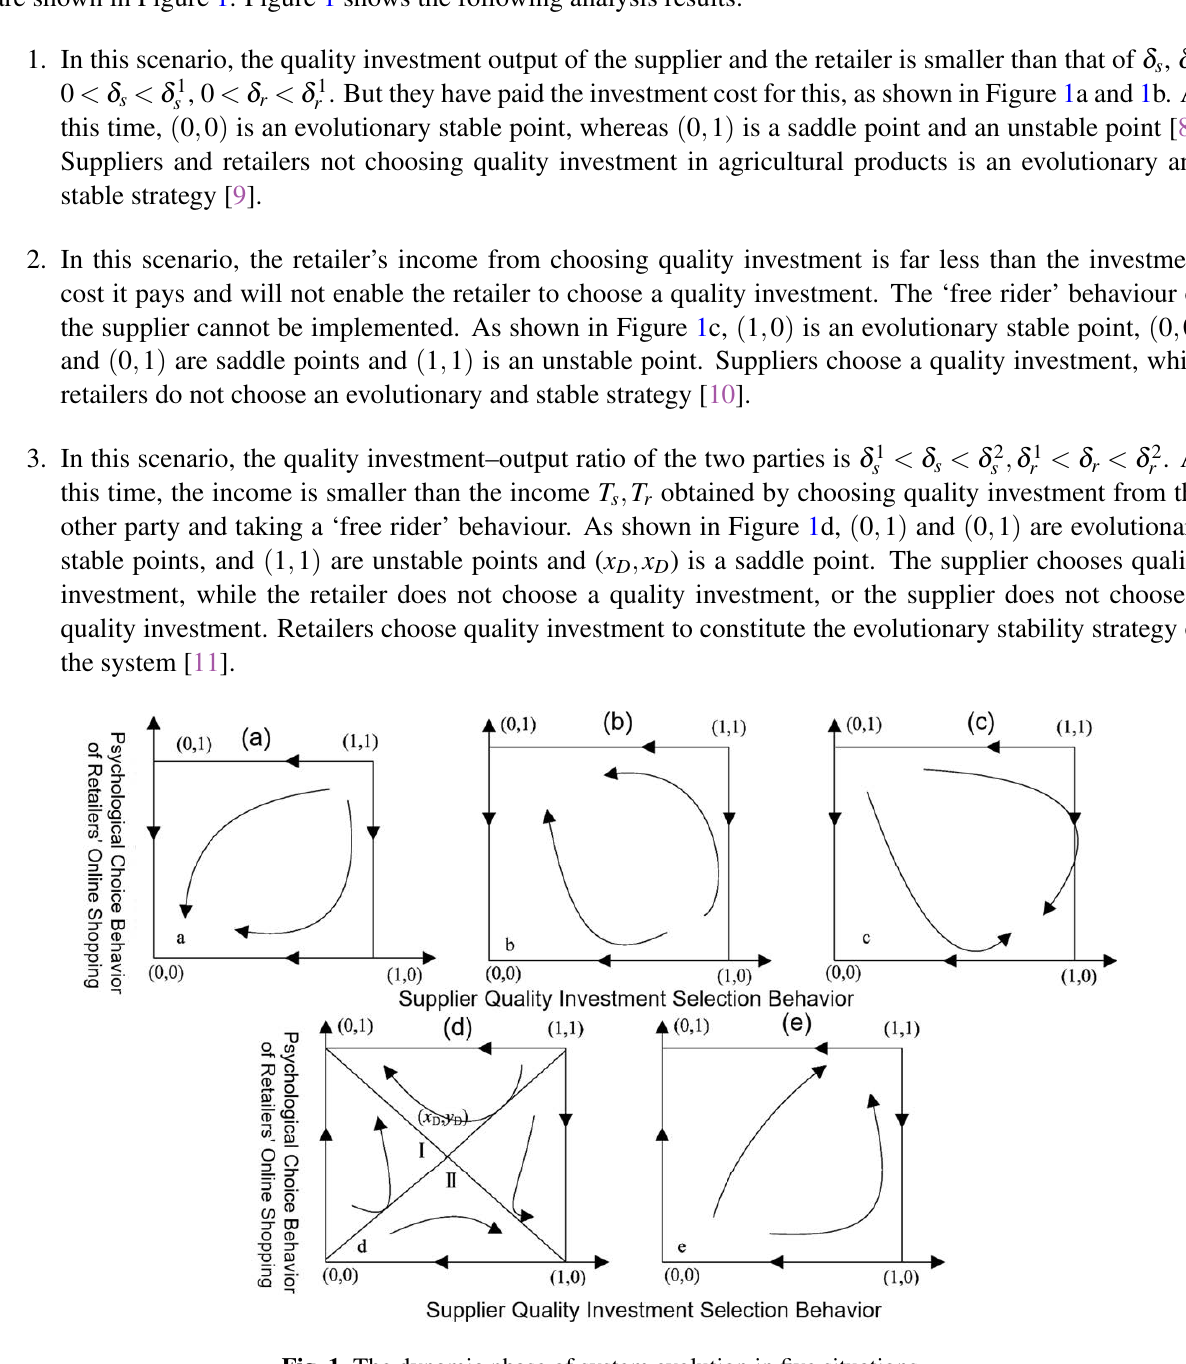
Fig. 1 The dynamic phase of system evolution in five